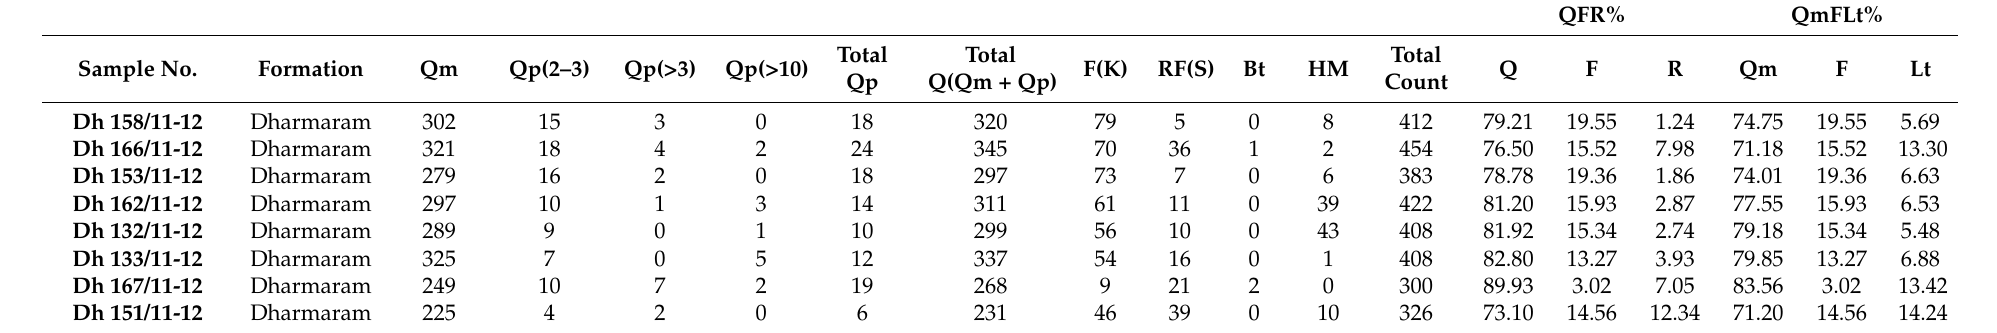
Table 3. Results of petrographic and modal analyses of sandstone samples of Yerrapalli, Bhimaram, Maleri and Dharmaram